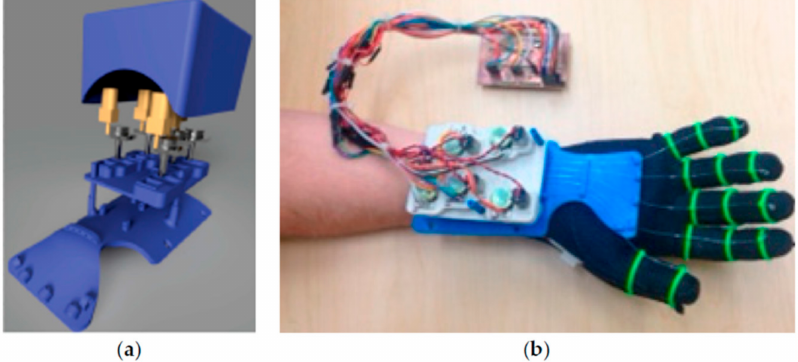
Figure 6. A soft robotic glove designed for remote application. ( a ) Mechanical design and ( b ) fully assembled exoskeleton connected to the microcontroller [71] (Open